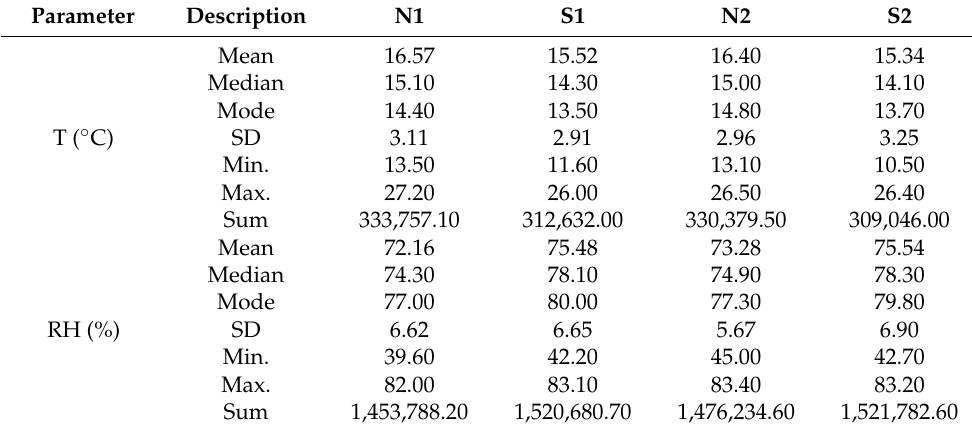
Table 10. Descriptive statistics of T, RH, VPD, and CO 2 distribution in the fifteen-span greenhouse. T: air temperature; RH: relative humidity; T dp : dew point temperature; VPD: vapor pressure deficit; SR: solar radiation; CO 2 : carbon dioxide; N1, S1, N2, S2: experimental sensors; SD: standard deviation; Min.: minimum; Max.: